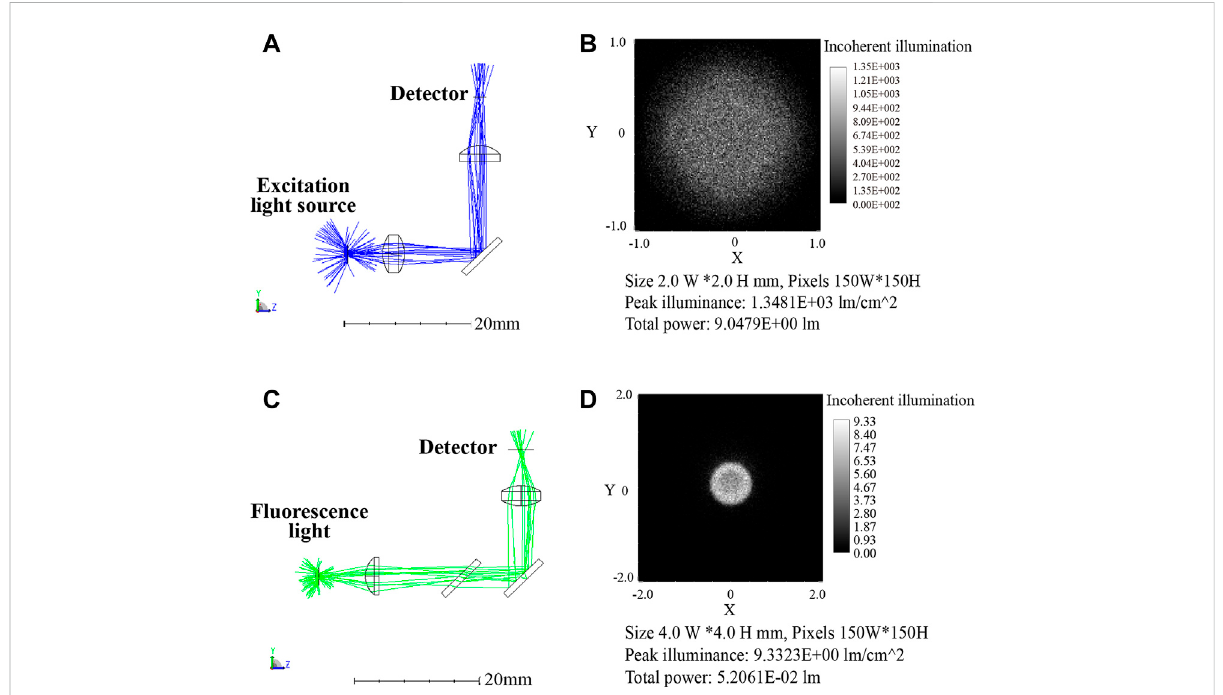
FIGURE 6 First channel optical paths (excitation/emission: 470 nm/525 nm) simulation diagram (A) 3D layout of the excitation optical path. (B) Image of the excitation optical path detector with 9.05 l m total power. (C) 3D layout of the emission optical path. (D) Image of the emission optical path detector with 5.2 × 10 -2 lm total power.